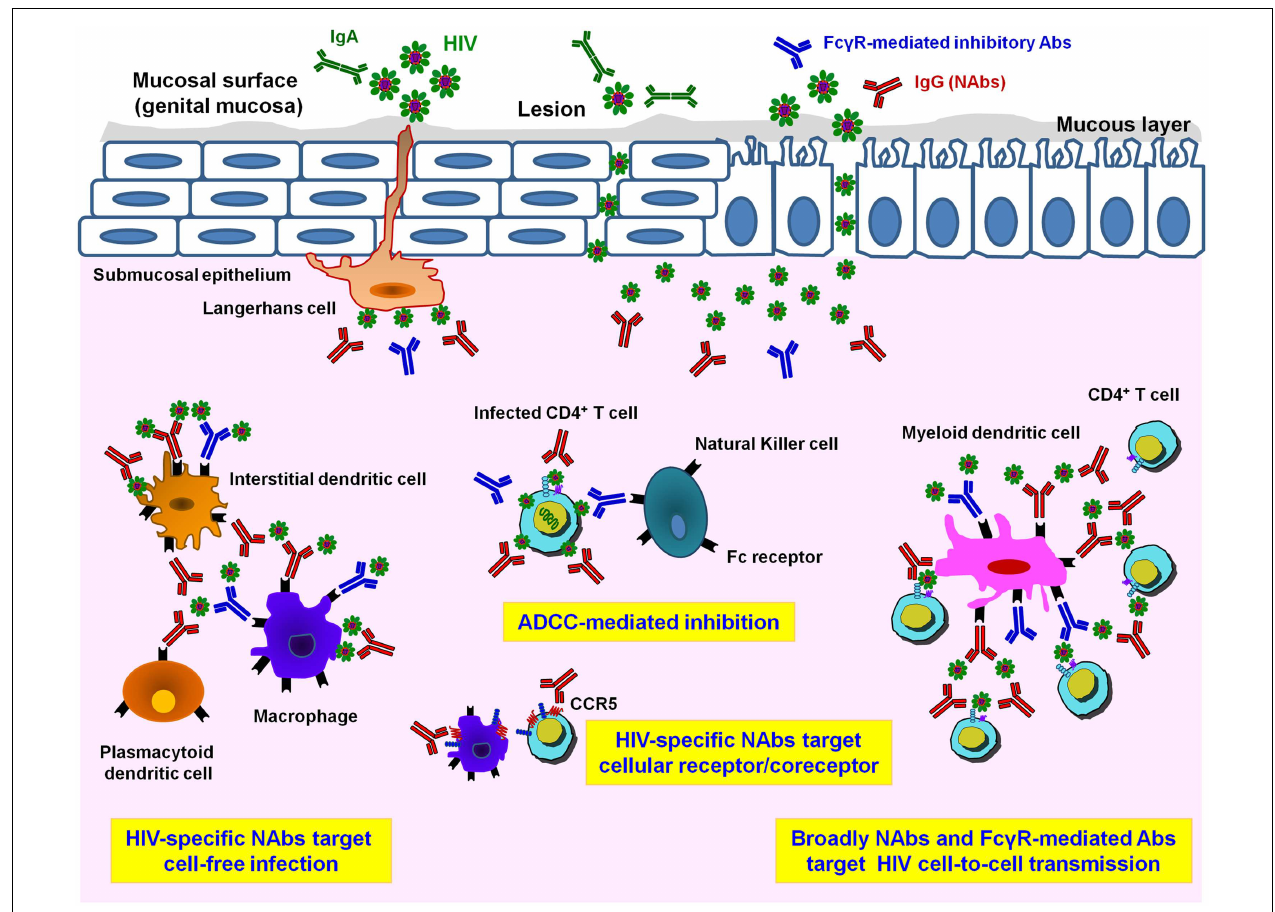
preventing HIV-1 cell-free infection. Only NAbs are able to inhibit HIV infection of CD4T lymphocytes while both NAbs and Fc γ R-mediated inhibitory Abs (in blue) help to inhibit the spread of infection via cell-to-cell transmission route. Prevention of HIV-1 infection and killing of virus-producing cells by Ab-dependent mechanisms, especially antibody-dependent cellular cytotoxicity (ADCC) via binding of Fc receptors presented on the surface of innate immune cells such as natural killer (NK) cells, monocytes, DCs, or macrophages, takes place by inhibiting viral replication and diminishing